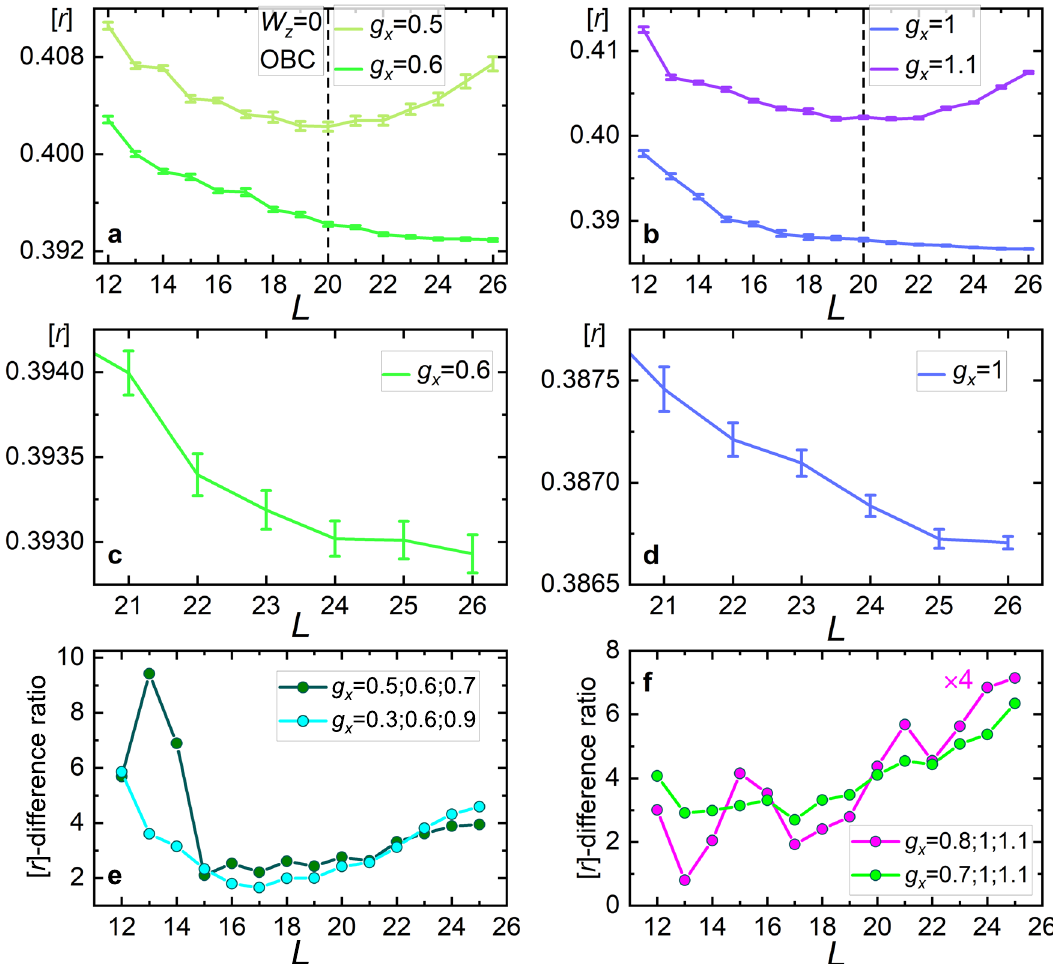
Fig. 2 [ r ] data at the left and right transition points. Dashed lines in a , b mark the lengths exceeding which the [ r ] values for g x = 0.5, 1.1 begin to grow. By contrast, c , d show the monotonic decrease of [ r ] at g x = 0.6, 1 toward r Poi . All data are taken from Fig. 1 with W z = 0. e , f